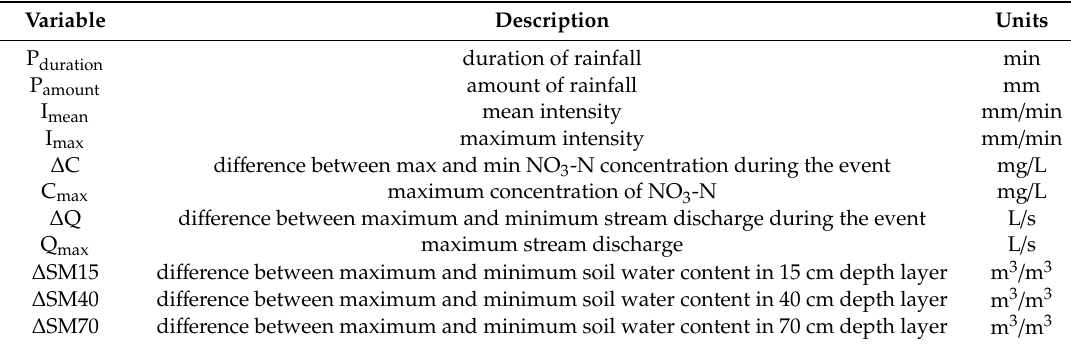
Table 2. Dependent variables taken into account to model LAG N (NO 3 -N flux lag time) and LAG Q (discharge lag time) using multiple linear